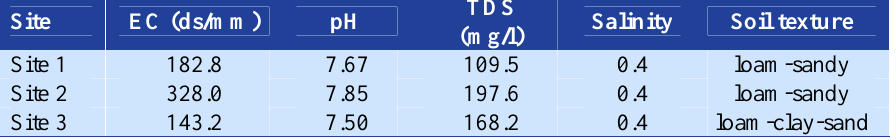
Table 2. Soil characteristics of the surrounding area in Ahangaran